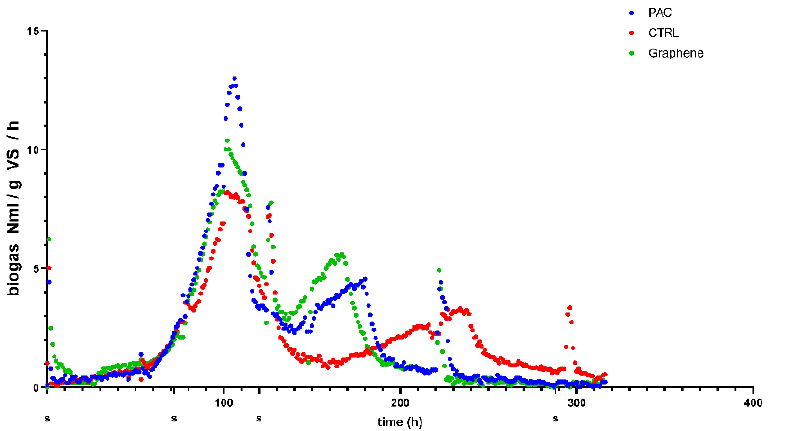
Figure 7. Hourly biogas production rate comparing CTRL (red line), PAC (blue line) and graphene (green line). S in the x-axes stands for sampling time.